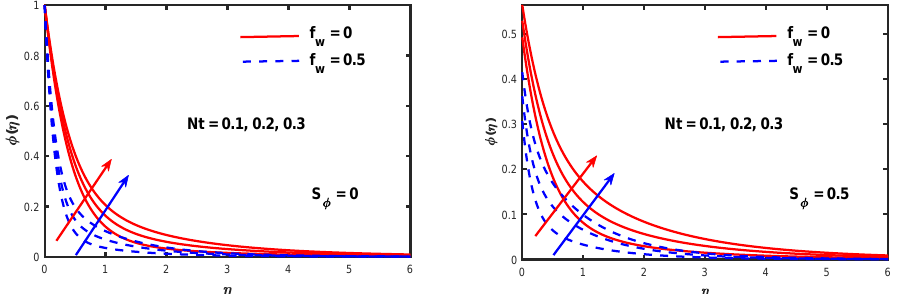
Figure 15. Influence of suction/injection and thermophoresis parameter on φ